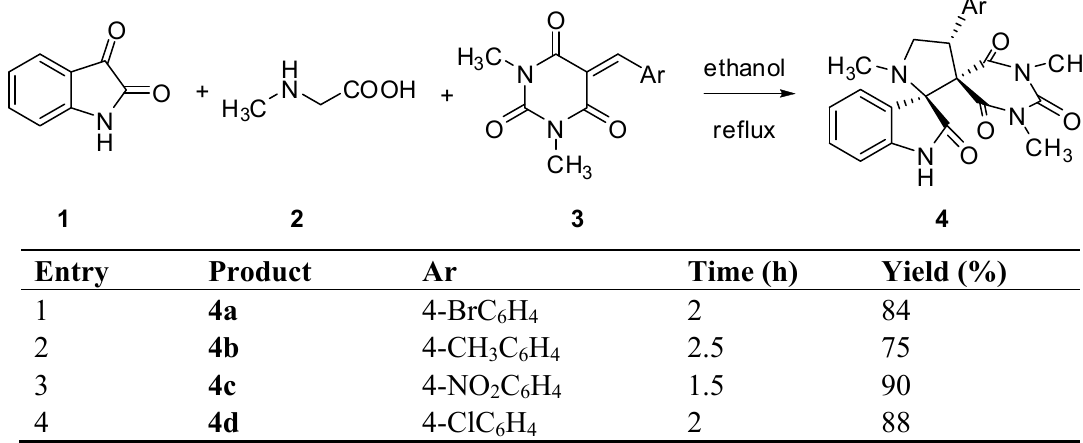
Table 2. Synthesis of dispirooxindole derivatives 4 via three-component